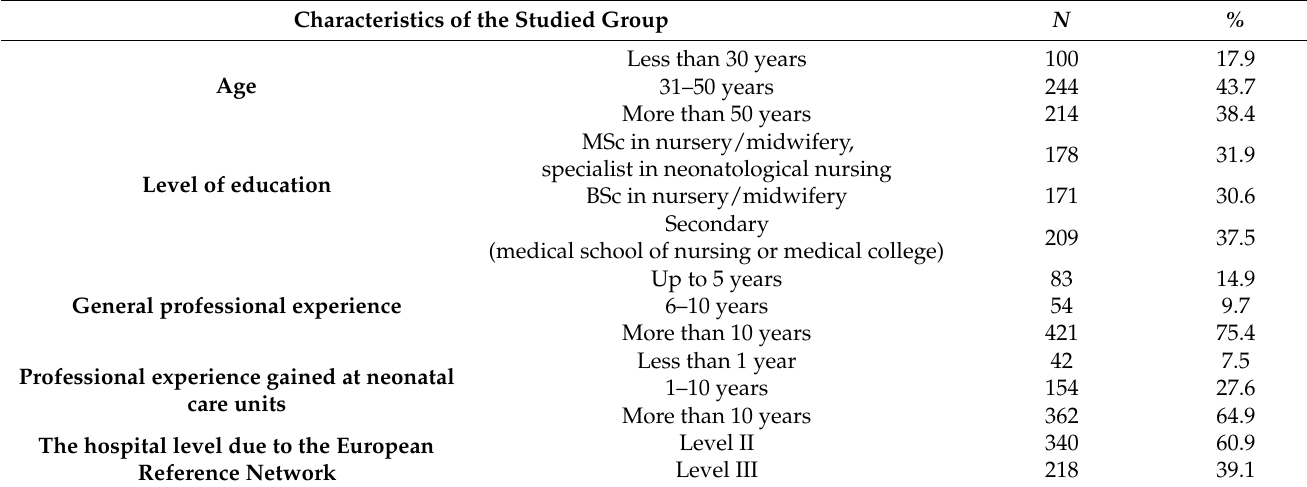
Table 2. Sociodemographic